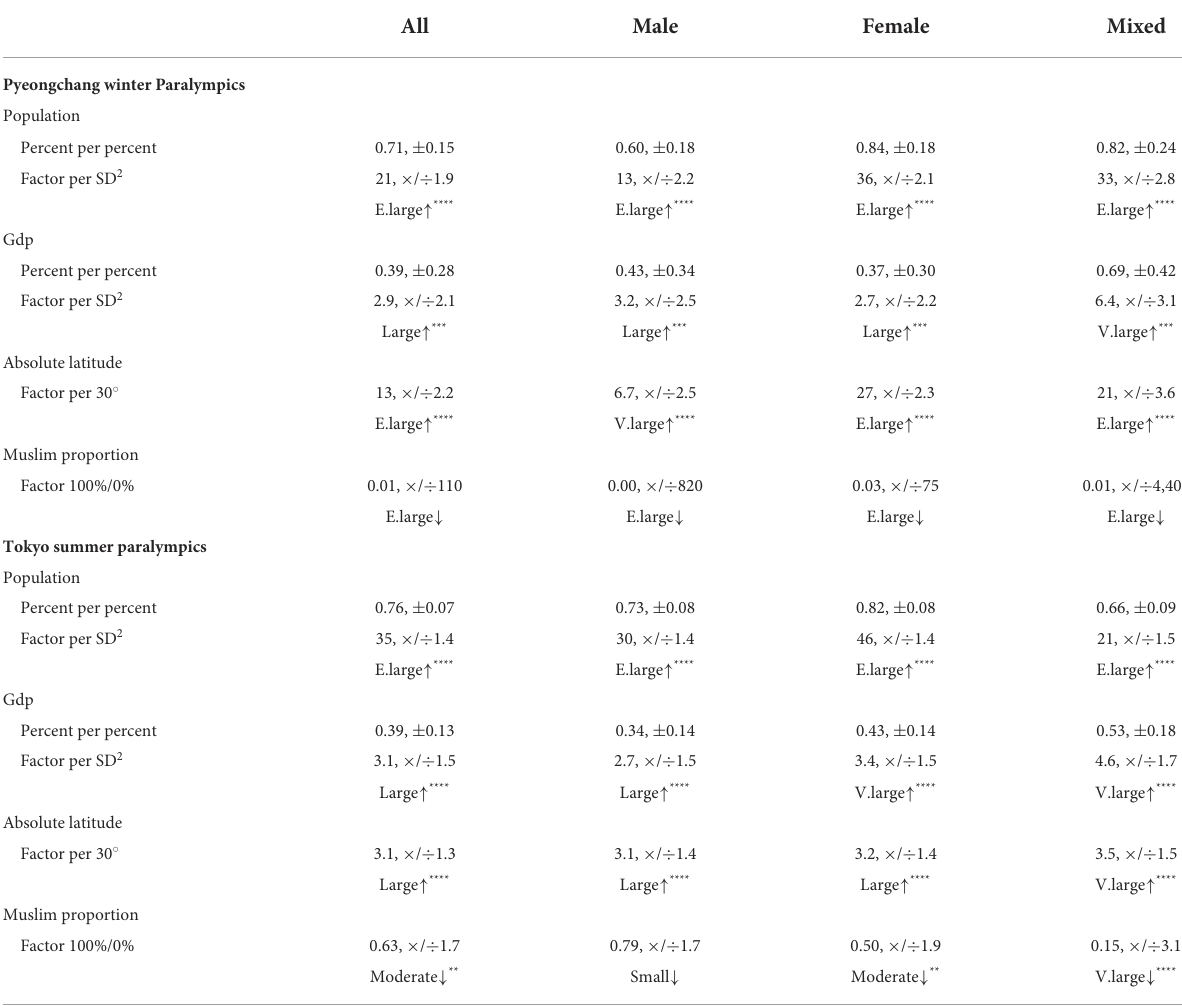
TABLE 8 Effects of population, gross domestic product per capita (GDP), absolute latitude and proportion of Muslims on medal counts in all, male, female, and mixed events provided by multiple linear Poisson regression for the Pyeongchang winter Paralympics and the Tokyo summer Paralympics. Male Female